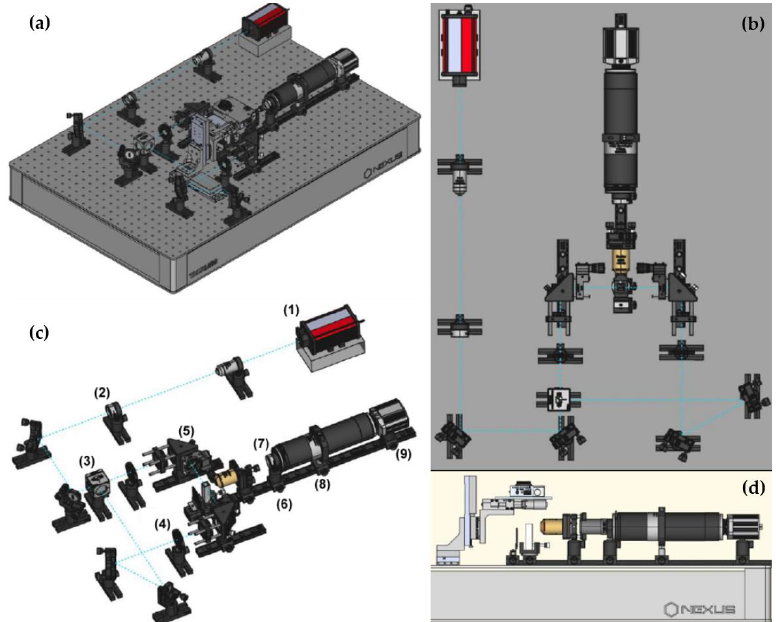
Figure A1. Schematic representation of the experimental microscope setup. ( a ) Three-dimensional representation of LSFM system (isometric view). ( b ) Three-dimensional representation of the LSFM system without the sample mounting and monitoring system (isometric view). ((1) laser, (2) beam expander, (3) beam splitter, (4) pinholes, (5) cylindrical lens, (6) filters, (7) iris diaphragm, (8) tube lens, (9) camera.) ( c ) Top view of the path followed by the laser light beam. ( d ) Representation of the OPT system (lateral view). Drawings were generated using FreeCAD open source program. The microscope is equipped with a modulated laser diode source with a wavelength of 488 nm (60 mW, Cobolt 06-MLD 488 nm). In the illumination path, the laser beam is expanded using a telescope system composed of a microscope objective lens (Hertel & Reuss, 40× numerical aperture (NA): 0.65) and an achromatic lens (AC254-200-A, Thorlabs, Newton, NJ, USA). A beam splitter (BS019, Thorlabs, Newton, NJ, USA) is used to illuminate the sample more homogeneously from both sides. These identical illumina- tion units are composed of a cylindrical lens (f = 150 mm, LJ1629RM, Thorlabs, Newton, NJ, USA), which generates the light sheet, mounted in a rotation mount (CRM1LT, Thorlabs, Newton, NJ, USA) and a right-angle kinematic mirror (KCB1E, Thorlabs, New- ton, NJ, USA). Before each cylindrical lens, a pinhole allows adjusting the light sheet thick- ness and the illuminated field of view (FoV). In the detection path, the fluorescence signal is collected by a 4× Plan Fluor Nikon detection objective with a 17.20 mm working distance and 0.13 NA. Laser light is filtered out using different filters (525/45 nm (green filter), 561/LP nm (yellow filter) or 650/LP (red filter)), depending on the experiment. After the filter, and in front of an infinity-corrected tube lens (TTL200-A, Thorlabs, Newton, NJ, USA), a lever-actuated iris diaphragm (SM2D25, Thorlabs, Newton, NJ, USA) allows extending the depth of field (DoF) of the system. The collected fluorescence signal is imaged onto an ORCA-Flash4.0 V3 Digital CMOS camera (Hamamatsu, Japan) with 6.5 × 6.5 μm 2 pixels.